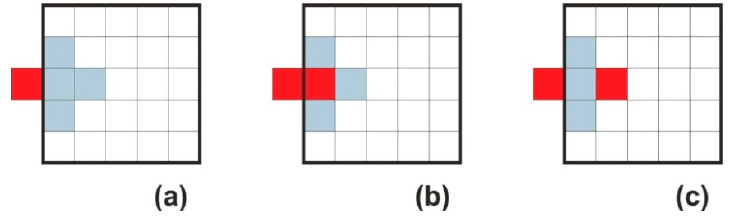
Figure 6. Boundary cells: ( a ) fixed; ( b ) adiabatic; ( c ) reflected.